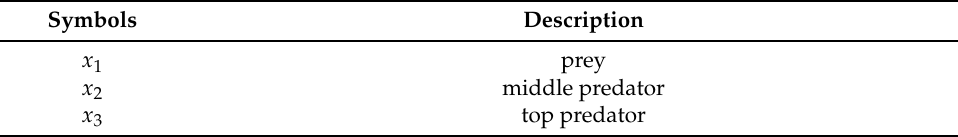
Table 1. Model symbols and description for Upadhyay and Rai